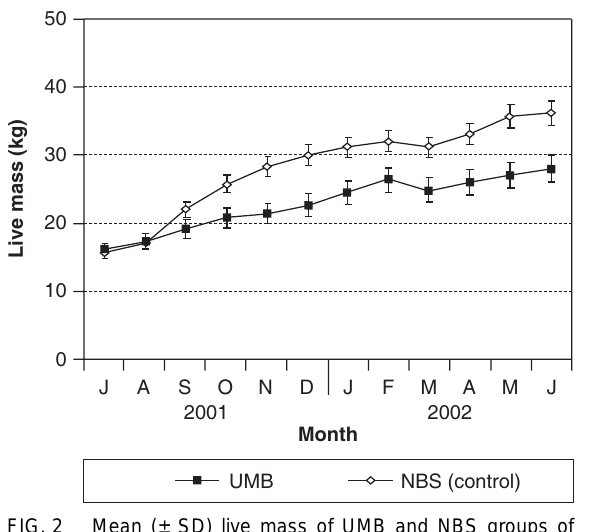
FIG. 2 Mean (± SD) live mass of UMB and NBS groups of goats during July 2001 to June 2002